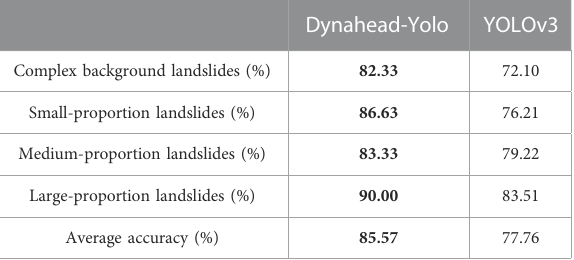
TABLE 1 Percentage of correct landslides detection with variable proportions and complex